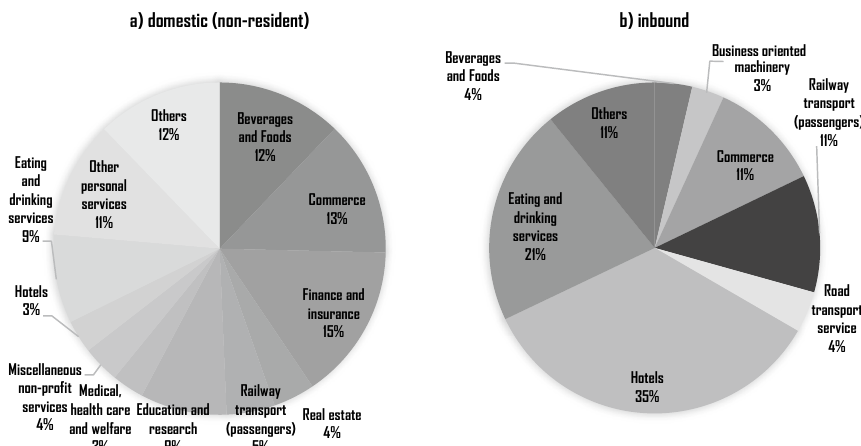
Fig. 3 Above-average domestic and inbound visitors’ expenditure in Tokyo by sector. Source: Tokyo